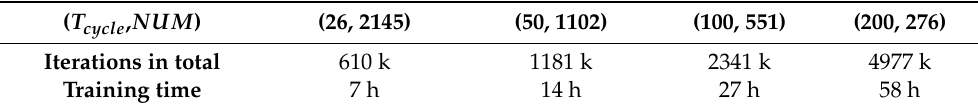
Table A31. The details of training time for different values of T cycle and NUM with 64 batch size and 50 epochs per T cycle